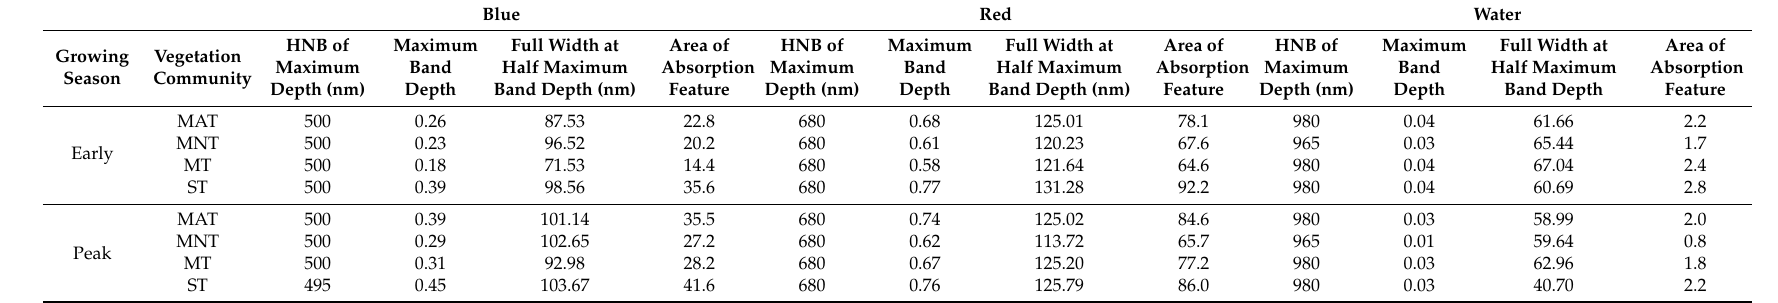
Table 5. Spectral metrics from continuum-removal analysis for the blue, red, and water absorption features at Ivotuk. Blue Red